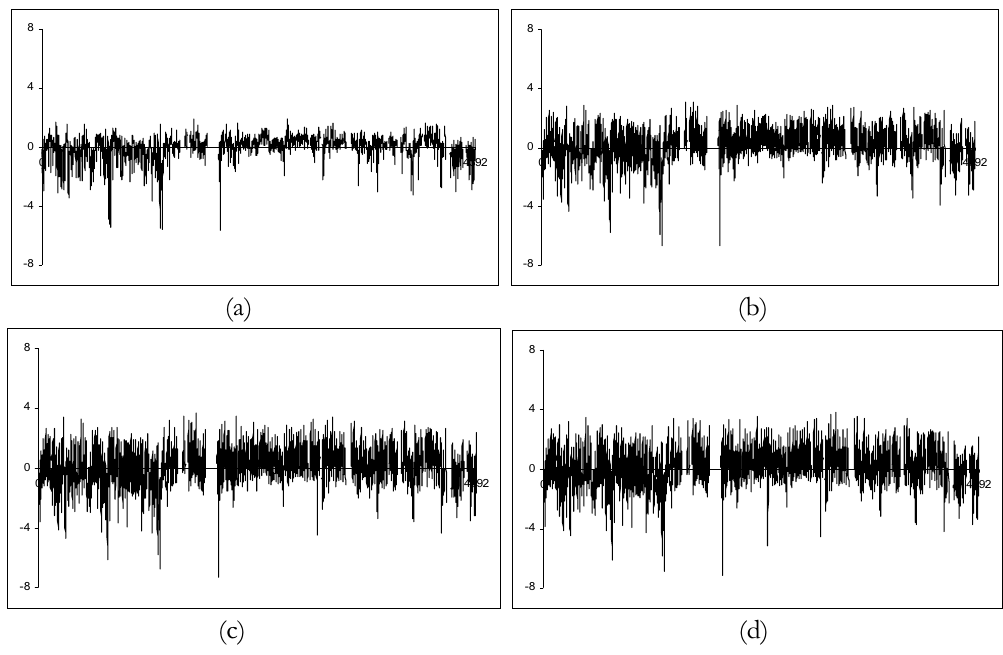
Figure 6 – The sequence of the predictive residuals for k =1 (a); k =6 (b); k =12 (c); k =24 (d).